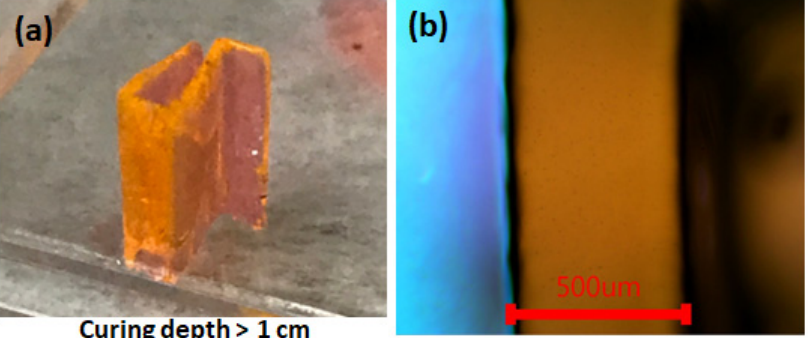
Figure 7. NIR-green light UC assisted laser patterning of a 3D structure in a single pass: ( a ) photo- graph; ( b ) optical microscope image of the top-down view of the sample.